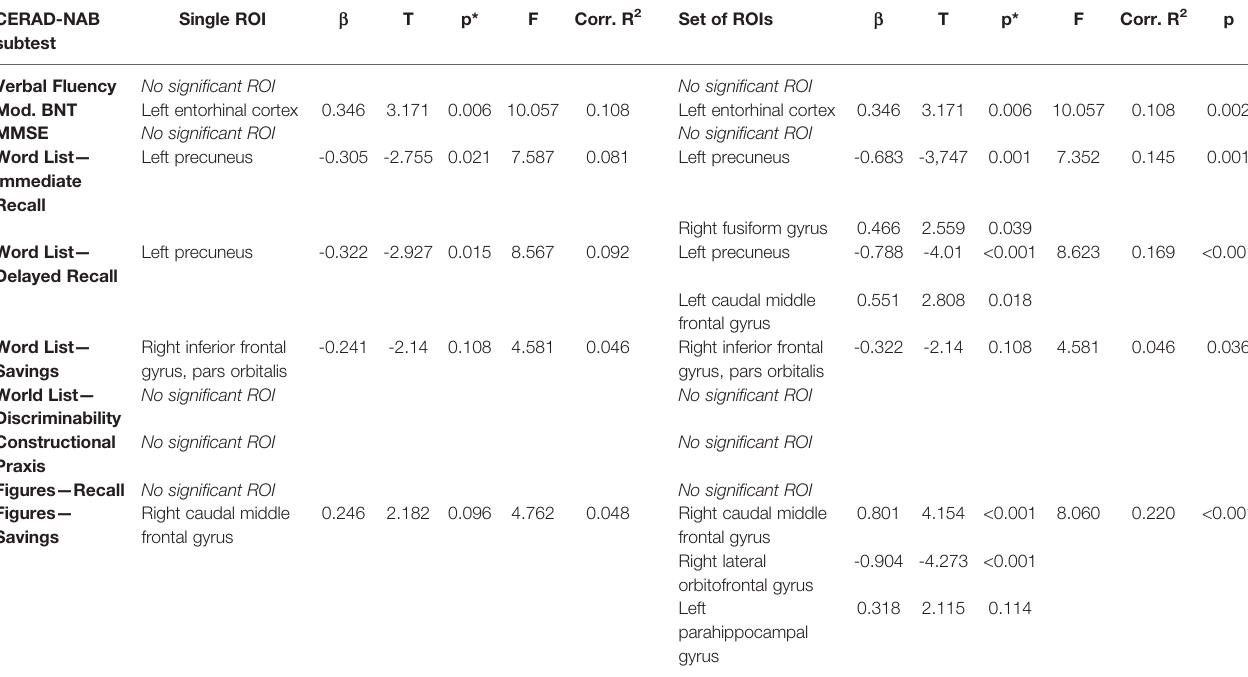
TABLE 2 | Relationship between cognitive performance and ROI-based amyloid deposition. CERAD-NAB